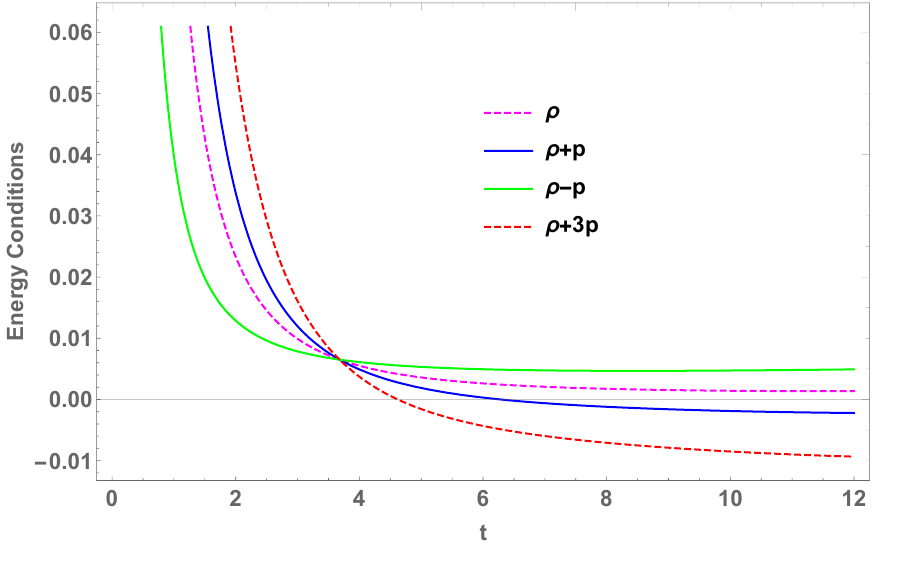
Figure 10. Behaviour of the energy conditions with respect to cosmic time t for β = − 20, γ = 1.65, k =